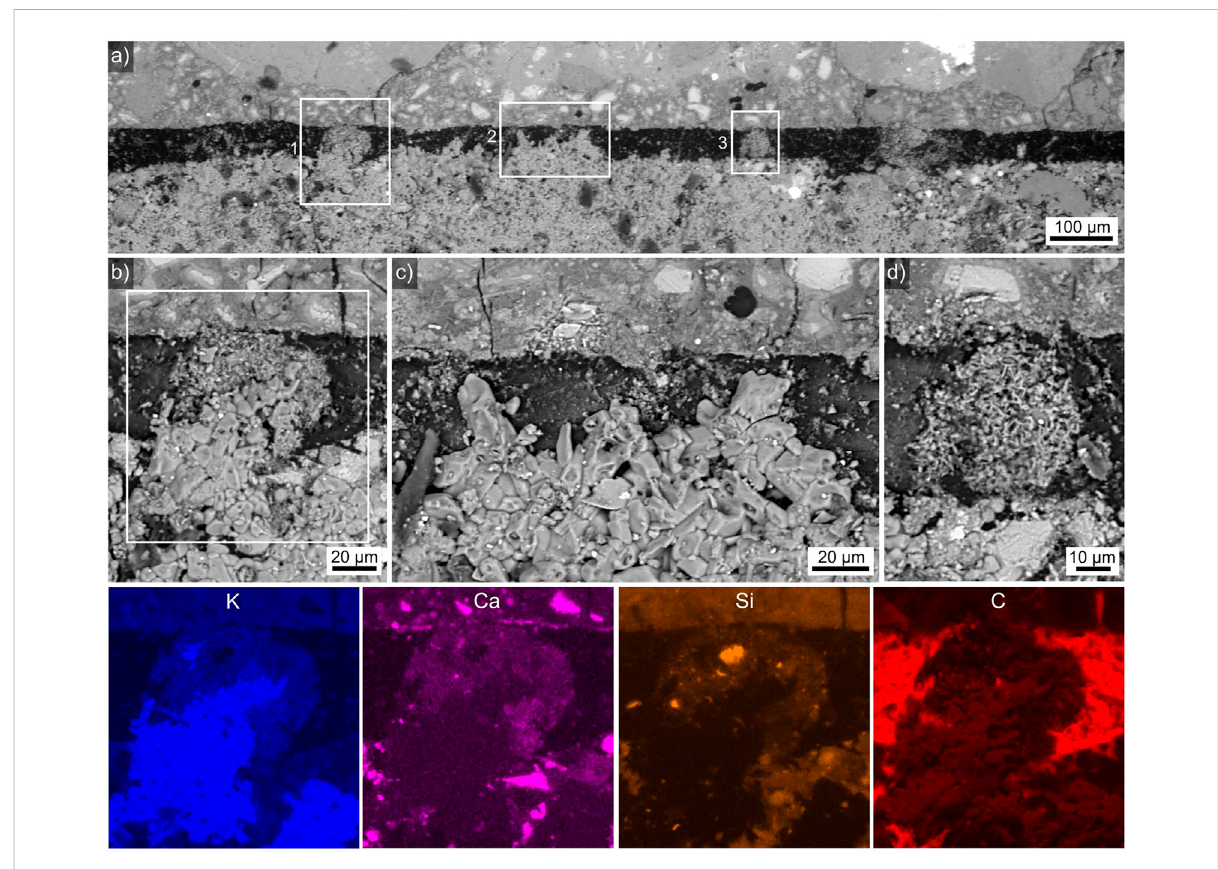
FIGURE 8 SEM-micrographsoftheinterfacebetweenetchedHDGP(top)andtheadhesivebatch1(bottom). (A) Overviewoftheinterface,theareasinthe frames 1 – 3 are respectively presented in (B) , (C) and (D) in greater detail. Element maps of the area in frame 4 are presented